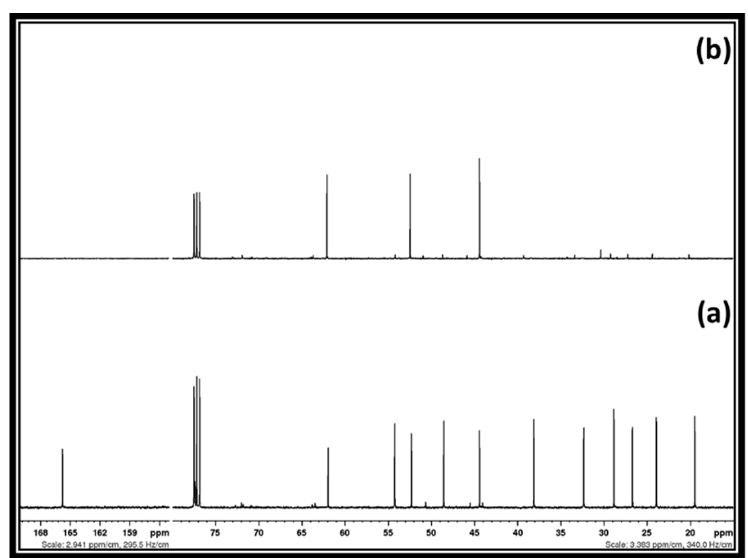
Figure 6 . 13 C NMR spectra: ( a ) [DBUH][Cl] salt and glycidol after removal of DMC and methanol and, ( b ) recovered glycidol .